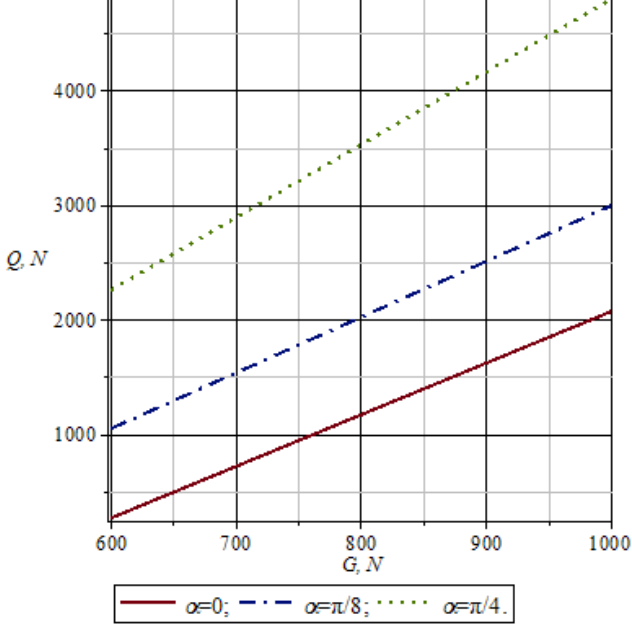
Figure 7. Graph of changes in the pressure force of the working rolls depending on the pulling force of conveyor chains. of conveyor chains.